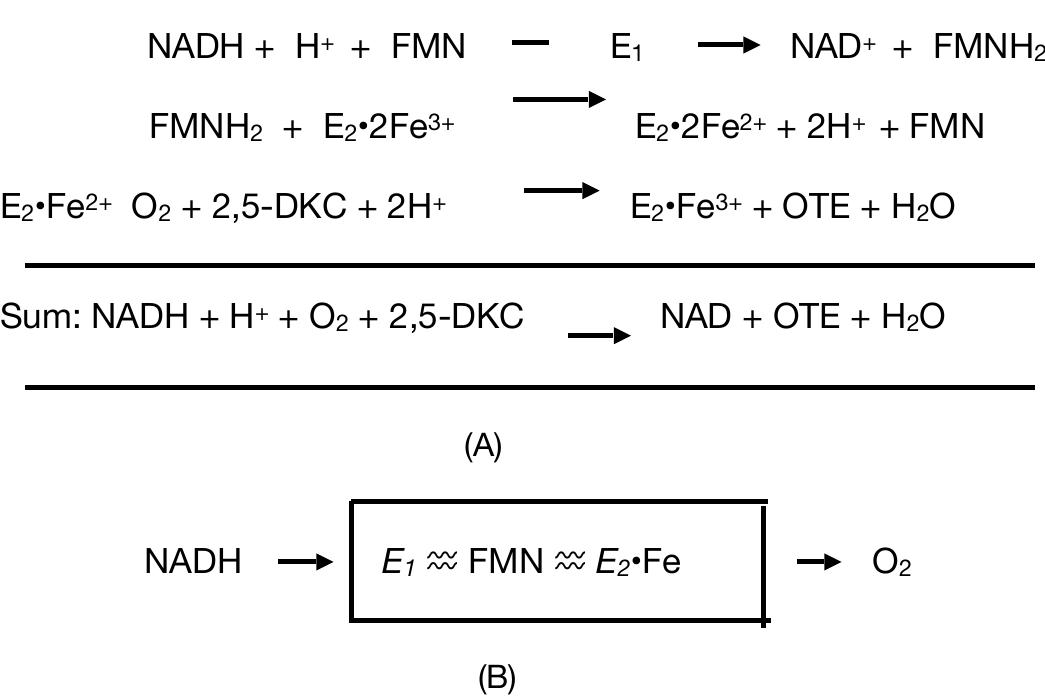
Figure 4. ( A ). Proposed reaction sequence for the combined action of E 1 and E 2 [41]. ( B ). Cartoon depicting the proposed functional complex between E 1 and E 2 [41]. E 1 = NADH oxidase; E 2 = 2,5-DKCMO; 2,5-DKC = 2,5-diketocamphane; OTE = 2-oxo- (cid:52) 3,4 -4,5,5-trimethylcyclopentenylacetic